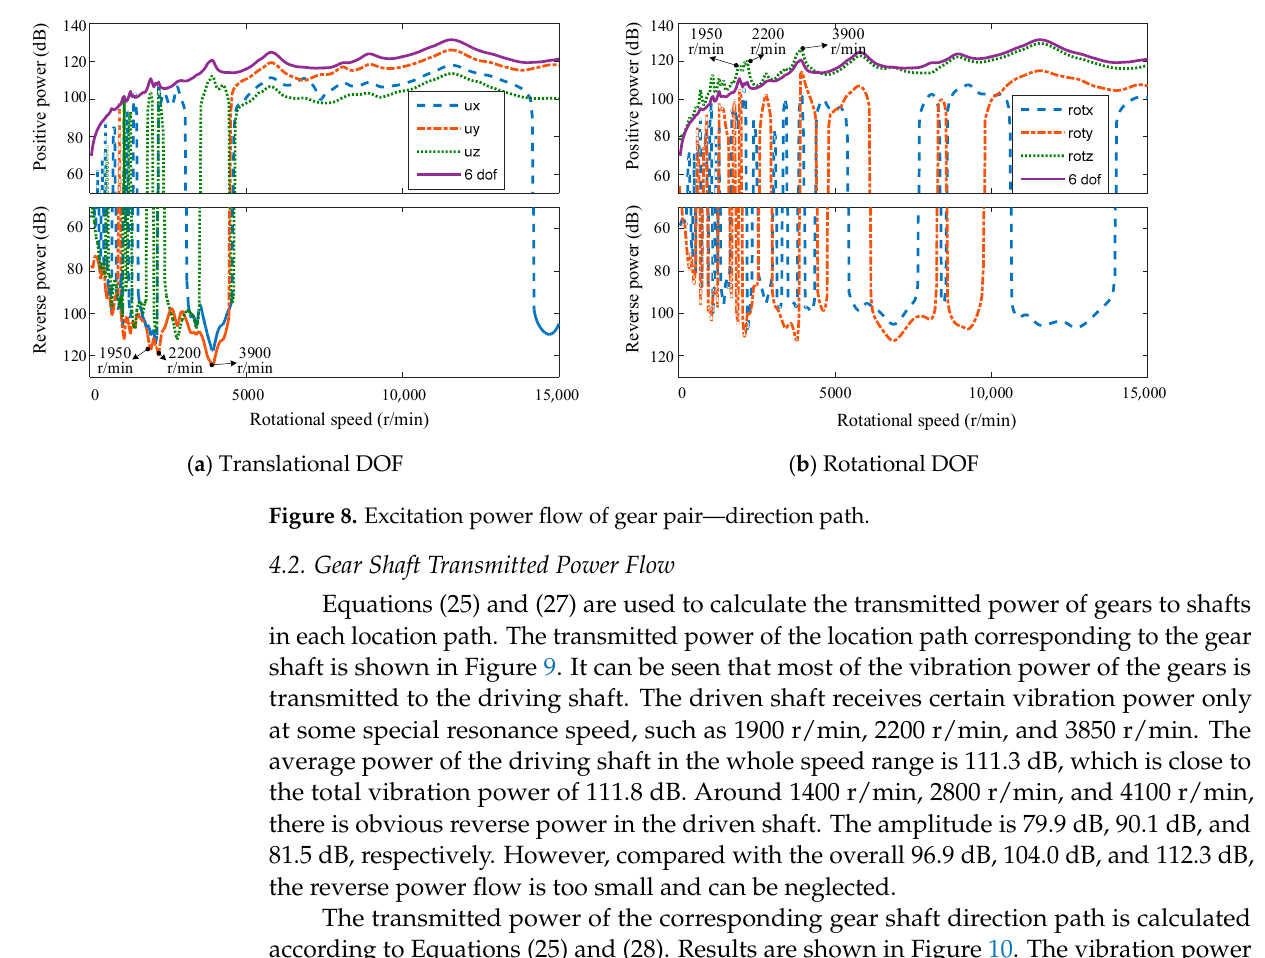
Figure 9. Gear shaft transmi tt ed power fl ow—location path. The transmi tt ed power of the corresponding gear shaft direction path is calculated according to Equations (25) and (28). Results are shown in Figure 10. The vibration power